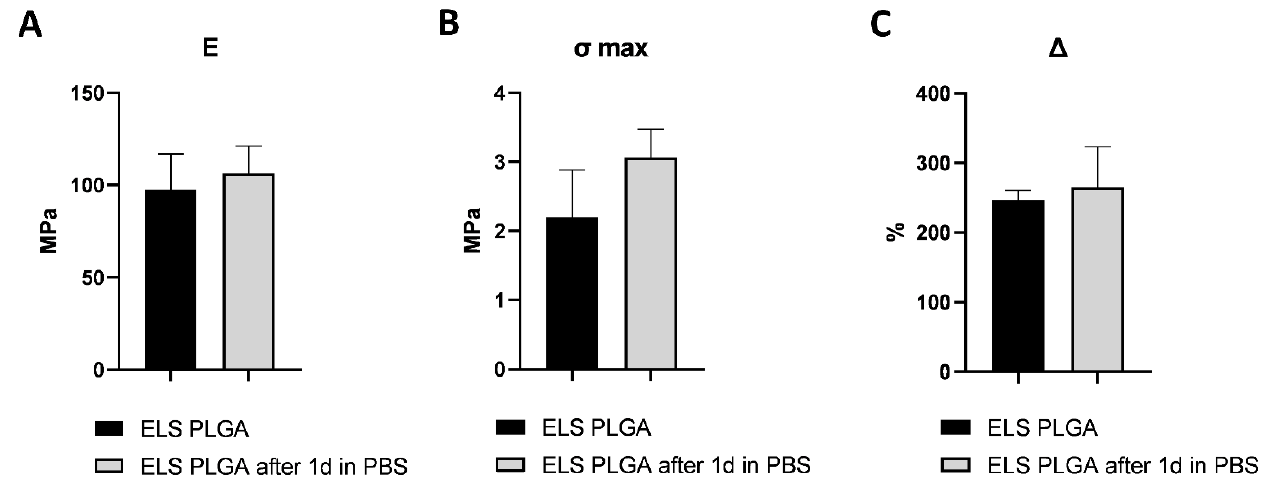
Figure 3. Tensile test results for dry ELS COL samples immersed in isopropanol with 15 wt.% BDDGE for 6 days, dried and immersed in PBS for 1 day: ( a ) Young’s modulus, ( b ) tensile strength, ( c ) maximum elongation. * p < 0.05 in Student’s t -test; data are the mean ± SD of at least 3 replicates.